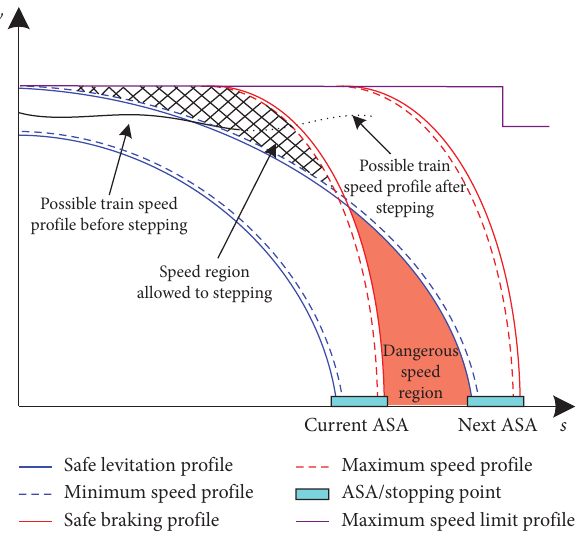
Figure 1: Stopping point stepping mode of the